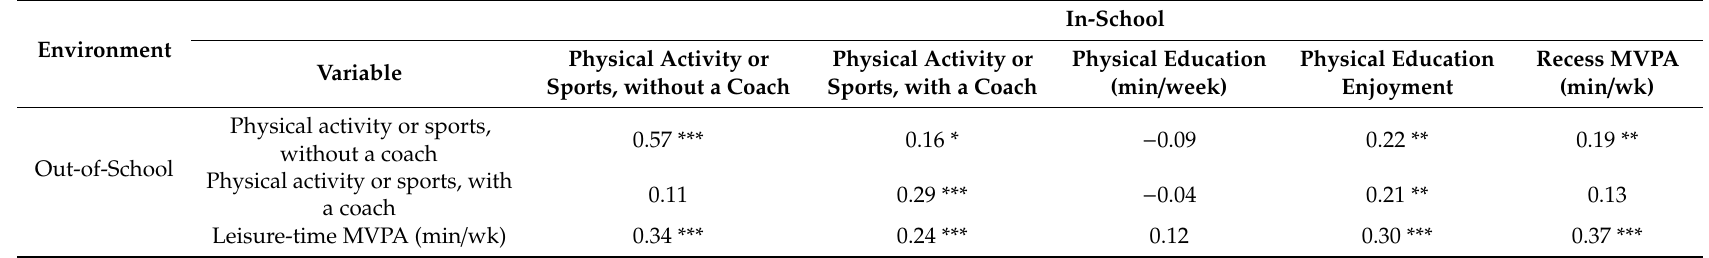
Table 3. Spearman correlations between in-school and out-of-school physical activity.